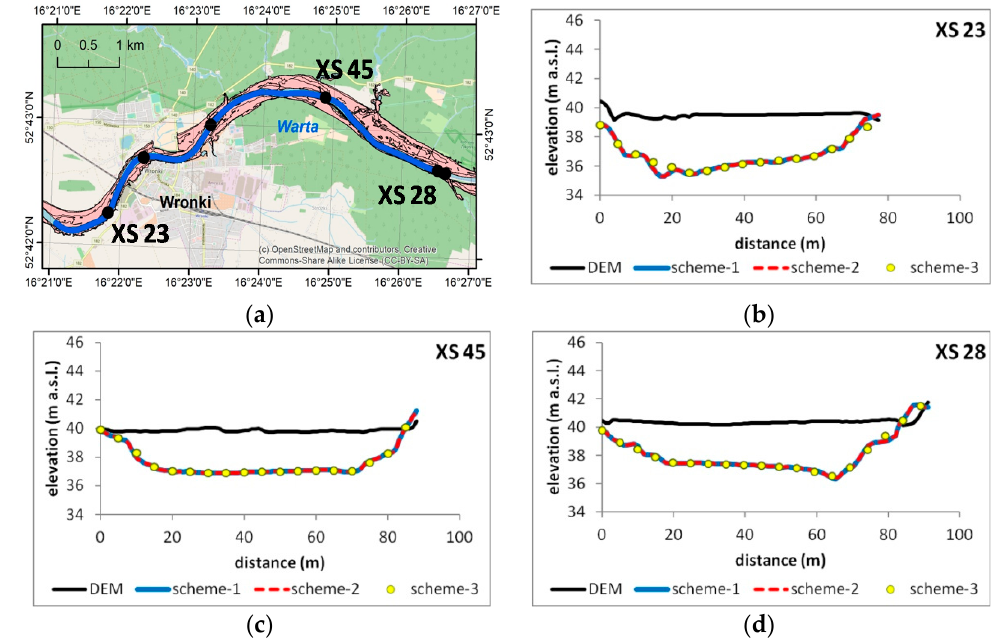
Figure 9. Comparison of selected cross-sections for the Warta river: ( a ) Map with locations of the cross-sections used for comparison; ( b – d ) Compared cross-sections.